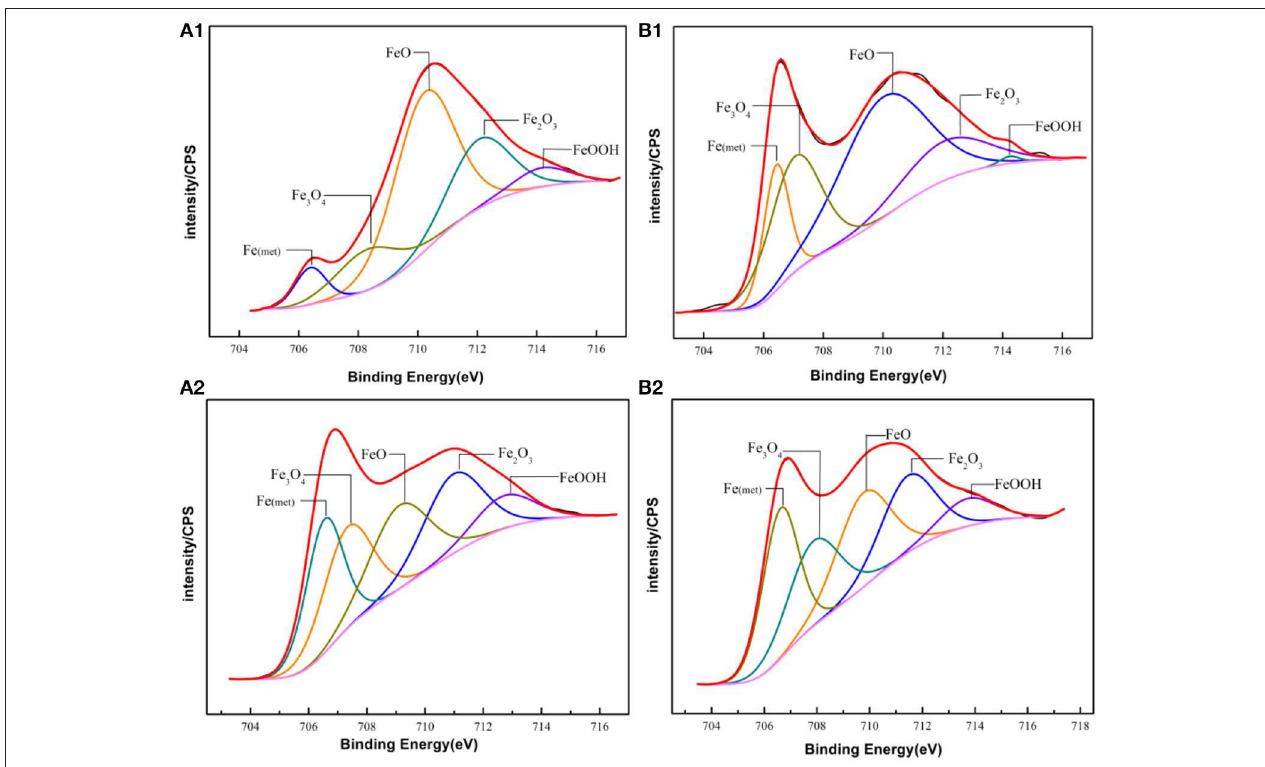
FIGURE 7 | Experimental and fitted narrow XPS spectra of Fe 2p 3 / 2 of the surface film of (A1,B1) Bare and pre-passivated sample before exposure; (A2,B2) Bare and pre-passivated sample after 5 year exposure.